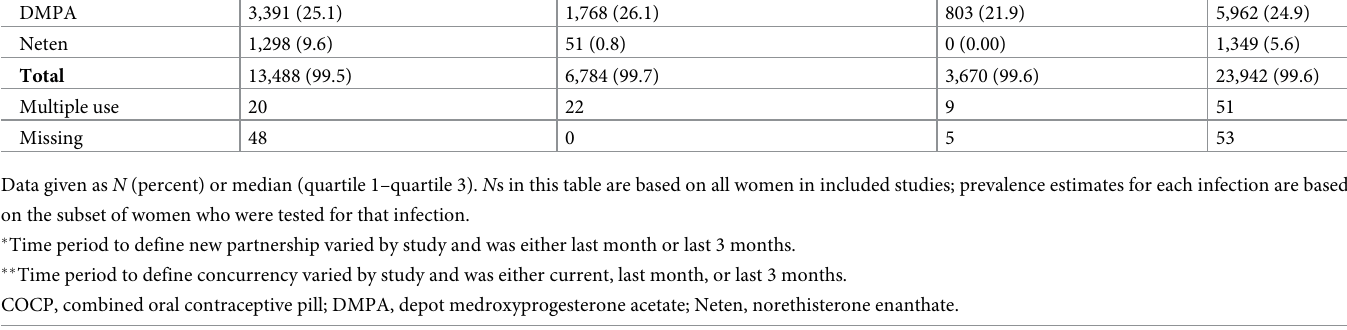
aged 25–49 years were similar to those in younger populations, but were more heterogeneous (Fig 8). The 17 studies included in the estimation of high-titer, active infectious syphilis prevalence are a subgroup of the studies included in the estimation of overall syphilis prevalence; summary esti- mates of overall syphilis prevalence limited to these 17 studies are provided in S9 and S10 Figs. Trichomoniasis. For both age groups, there was high heterogeneity in estimates of tricho- moniasis prevalence across all strata (Figs 9 and 10). For example, among 15–24-year-olds in higher-risk populations in Eastern Africa, estimates ranged from 6.6% to 29.7% (summary estimate: 12.7% [95% CI: 7.5%, 20.6%]; I 2 = 93.1%), and among 25–29-year-olds in the South African clinic/community-based populations, estimates ranged from 1.9% to 28.6% (summary estimate: 8.6% [95% CI: 6.5%, 11.5%]; I 2 = 95.2%). HSV-2. In general, HSV-2 prevalence was high among 15–24-year-olds, ranging from 31.9% to 53.7% in the South African clinic/community-based populations (summary estimate: 39.3% [95% CI: 34.3%, 44.6%]; I 2 = 88.8%), 33.7% to 78.6% in Southern/Eastern African clinic/ community-based populations (summary estimate: 46.8% [95% CI: 38.2%, 55.6%]; I 2 = 95.4%), and 45.7% to 65.9% in the higher-risk populations in Eastern Africa (summary esti- mate: 56.3% [95% CI: 49.2%, 63.1%]; I 2 = 87.6%) (Fig 11). As expected due to the lifelong nature of HSV-2 infection, prevalence of HSV-2 was even higher among women aged 25–49 years (Fig 12). In the South African clinic/community- based populations, the summary estimate was 77.8% (95% CI: 75.6%, 79.9%; I 2 = 49.2%), simi- lar to summary estimates in Southern/Eastern African clinic/community-based populations (70.0% [95% CI: 61.8%, 77.1%]; I 2 = 97.2%) and in the higher-risk populations in Eastern Africa (83.3% [95% CI: 79.3%, 86.6%]; I 2 = 86.2%) (Fig 12). Bacterial vaginosis. Among 15–24-year-olds in the South African clinic/community- based populations, the summary estimate for BV prevalence was 42.1% (95% CI: 35.6%, 49.0%; I 2 = 90.0%), similar to the summary estimates in Southern/Eastern African clinic/community- based populations (35.2% [95% CI: 27.7%, 43.6%]; I 2 = 93.3%) and in the higher-risk popula- tions in Eastern Africa (49.5% [95% CI: 42.2%, 56.8%]; I 2 = 90.0%) (Fig 13). Prevalence was similar among women aged 25–49 years, with high heterogeneity across studies (Fig 14). Prevalence estimates for co-infection Patterns of co-infection among women tested for at least 2 infections at baseline varied across STI/BV combinations (Tables 4–9). In general, women with a specific infection had a